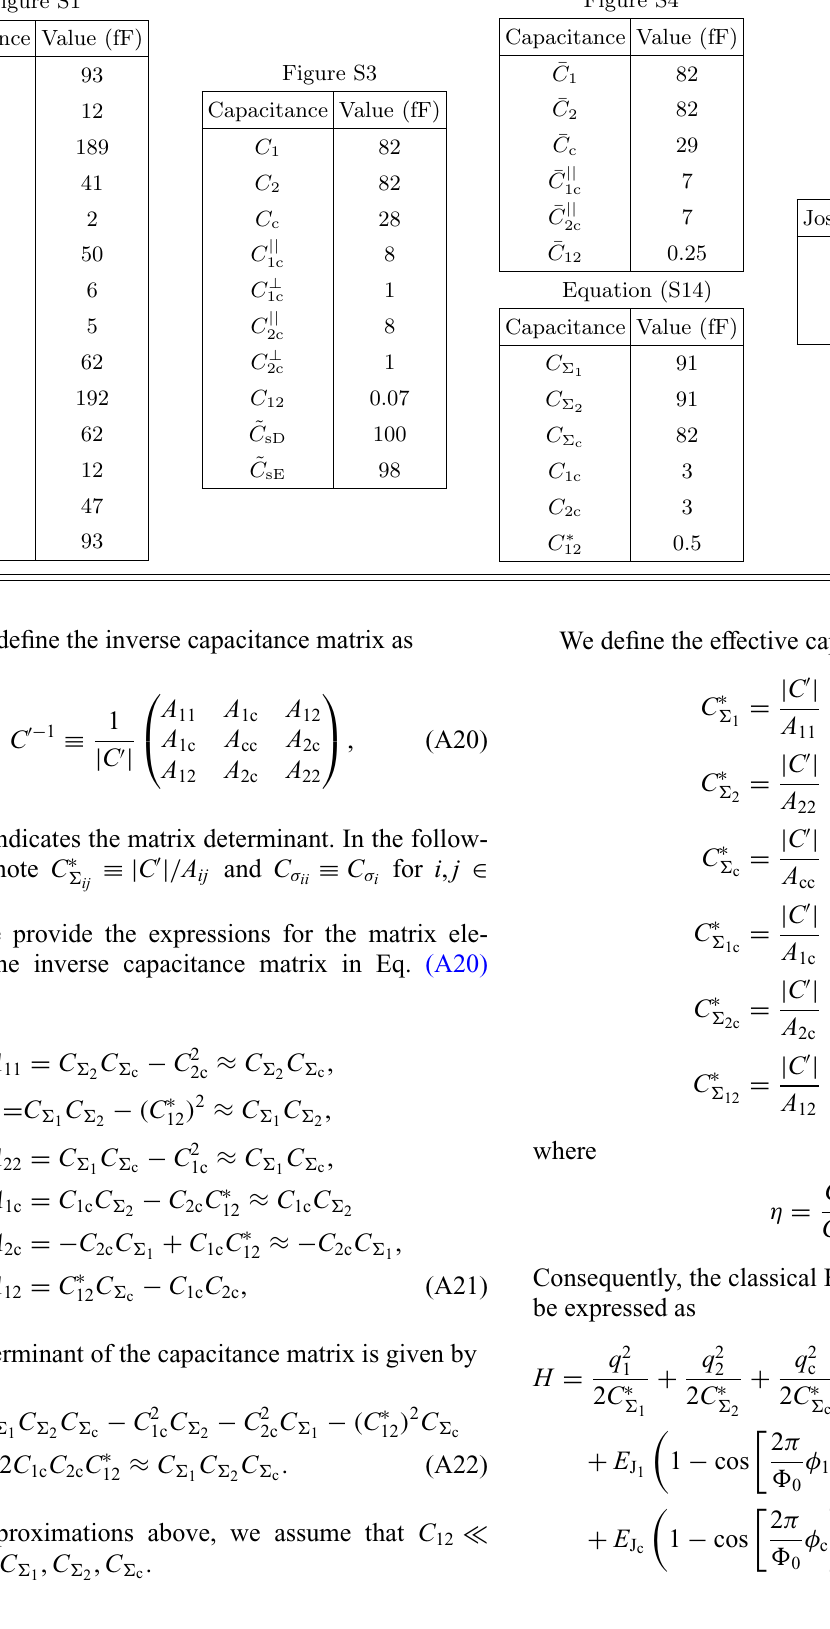
TABLE I. The lumped-element capacitance values for the models defined in Figs. 5–8. We also show the elements of the effective- capacitance matrix in Eq. (A14) and the designed values for the Josephson energies used in the models. Figure